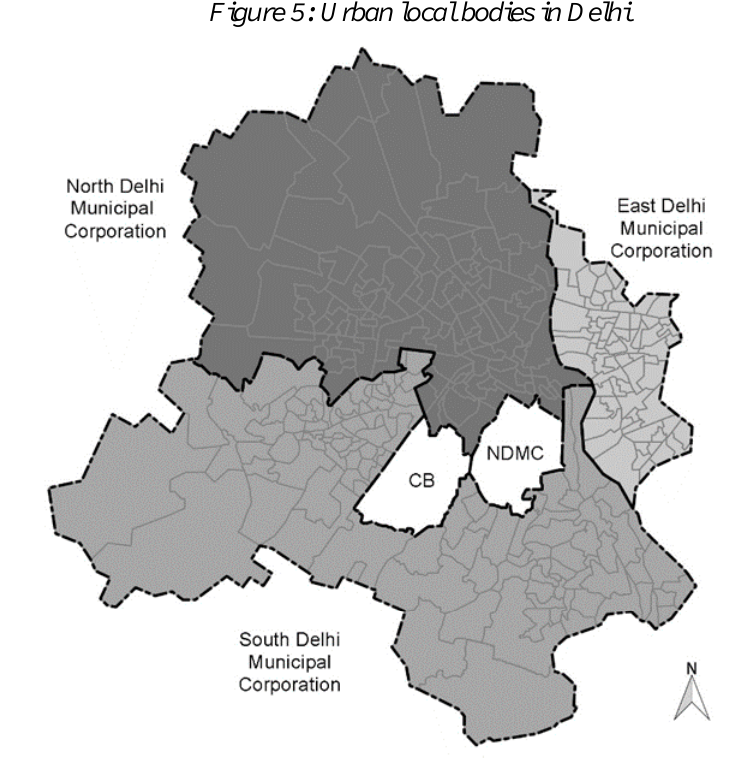
Figure 5: Urban local bodies in